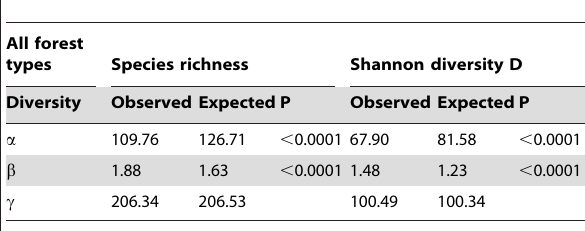
Table 3. Hierarchical multiplicative partitioning of a and b components for species richness and Shannon diversity D compared to expected values from 1000 randomizations with PARTITION V3.